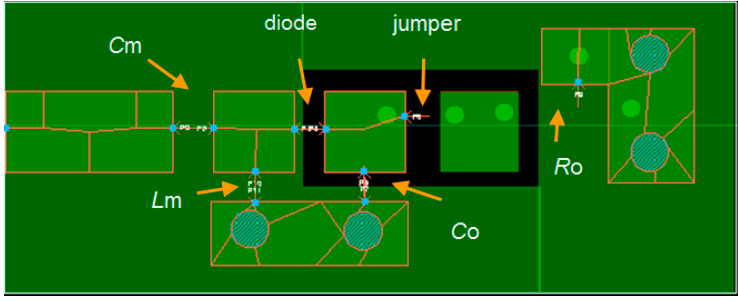
Figure 6. PCB Layout of the rectenna with indication to the placement of the components.